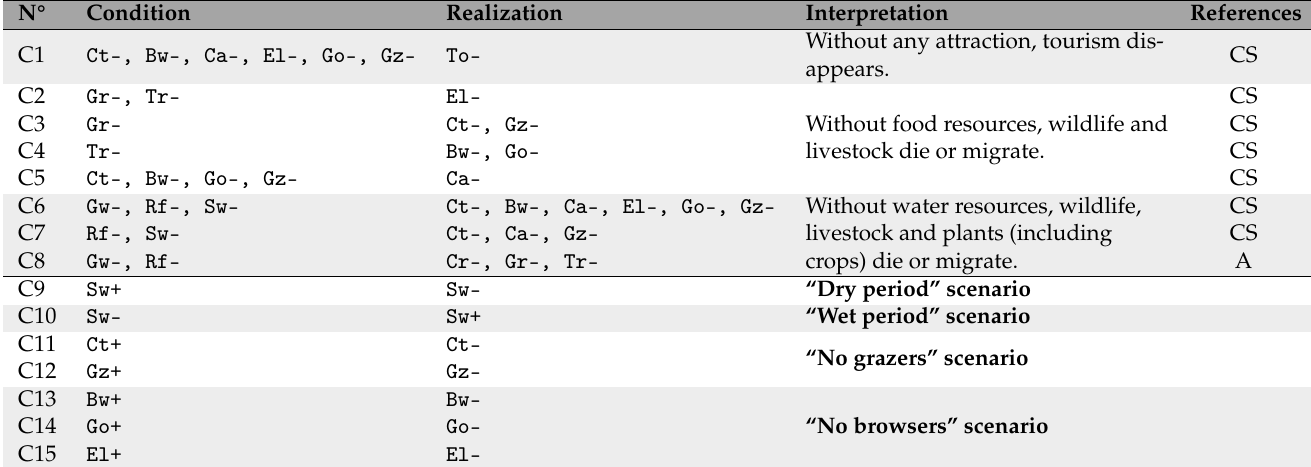
Table A1. Model constraints. Ecologically similar constraints share the same interpretation. Note the slight differences (in condition) between the various groups of plants and animals with respect to their resource requirements (food or water). Model scenarios correspond to versions of the reference scenarios in which some constraints have been added to represent a “press perturbation”, i.e., maintaining the value of some variables constant. Within a scenario (e.g., “No grazers”) all corresponding constraints are activated (i.e., C11 and